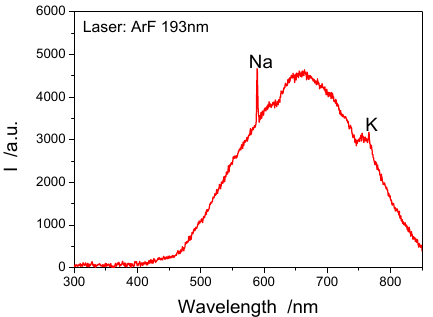
Figure 12. Experimental spectral data of SASN detonation by ArF 193 nm laser.